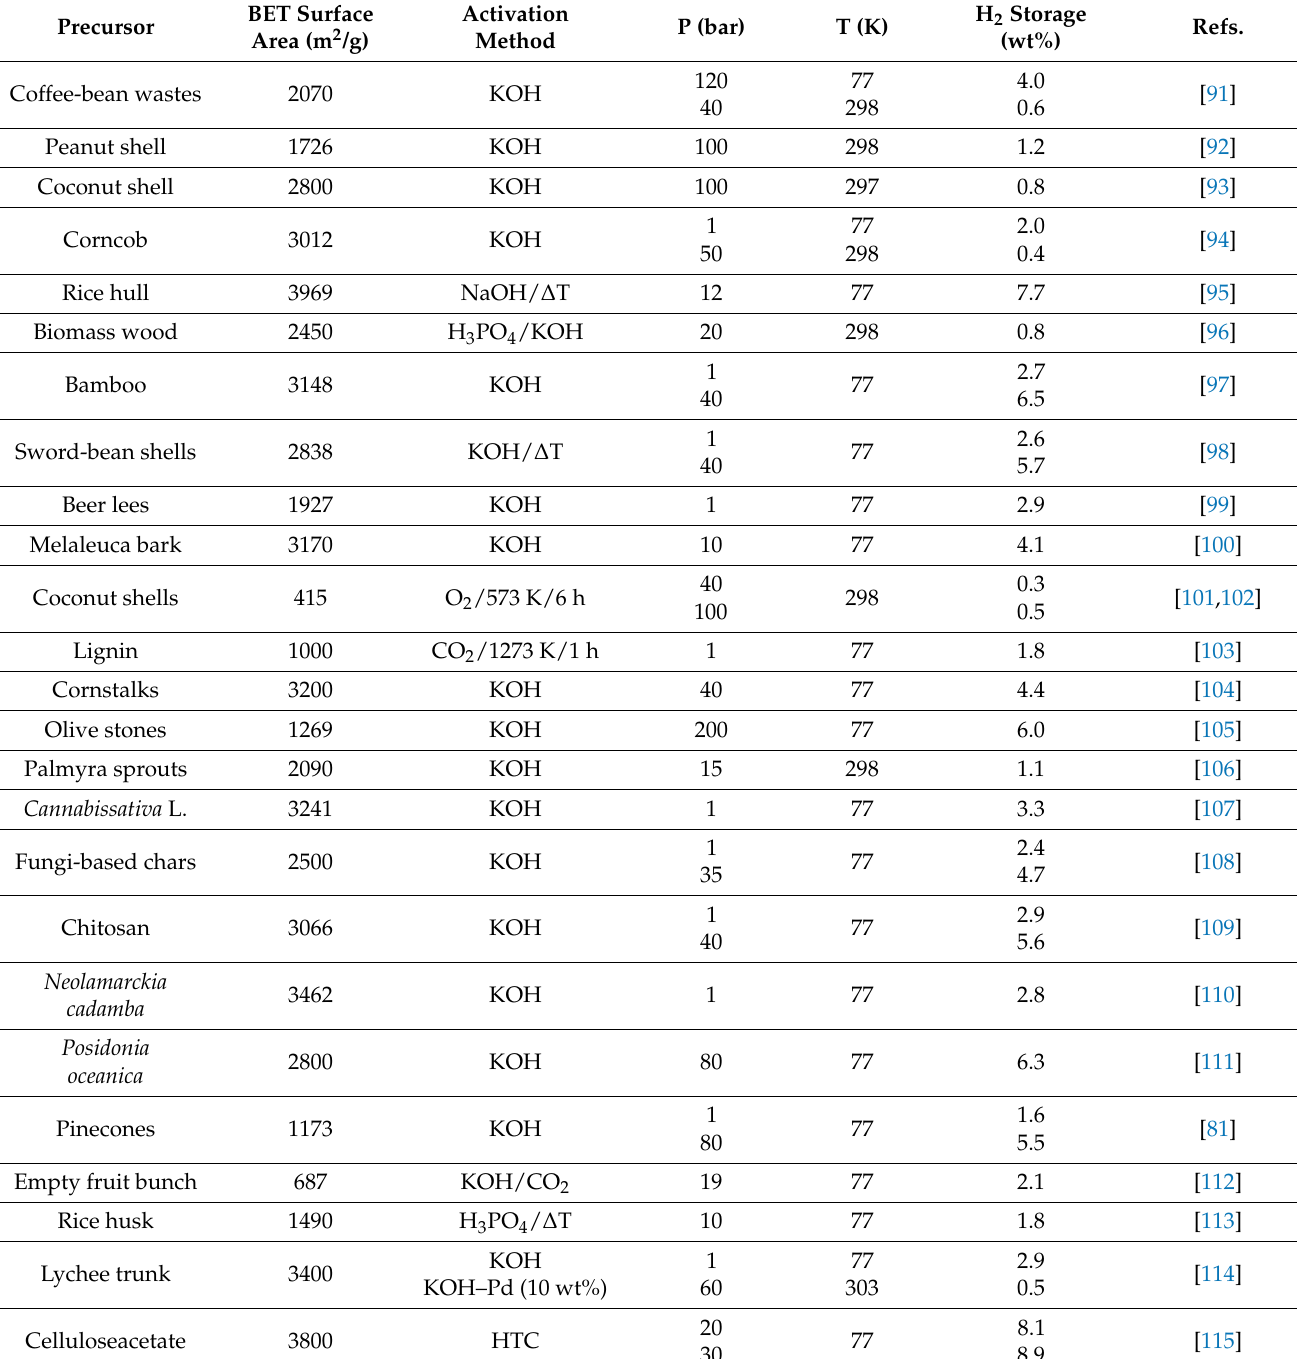
Table 2. Biomass-derived ACs, activation methods, and related hydrogen storage